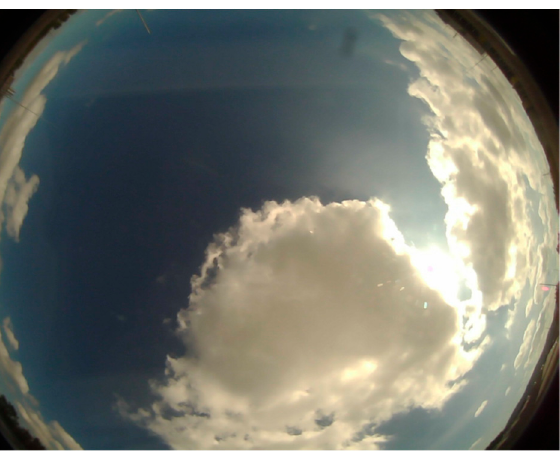
Figure 6. Exemplary training image with clouds, taken with the ground-based all-sky imager.